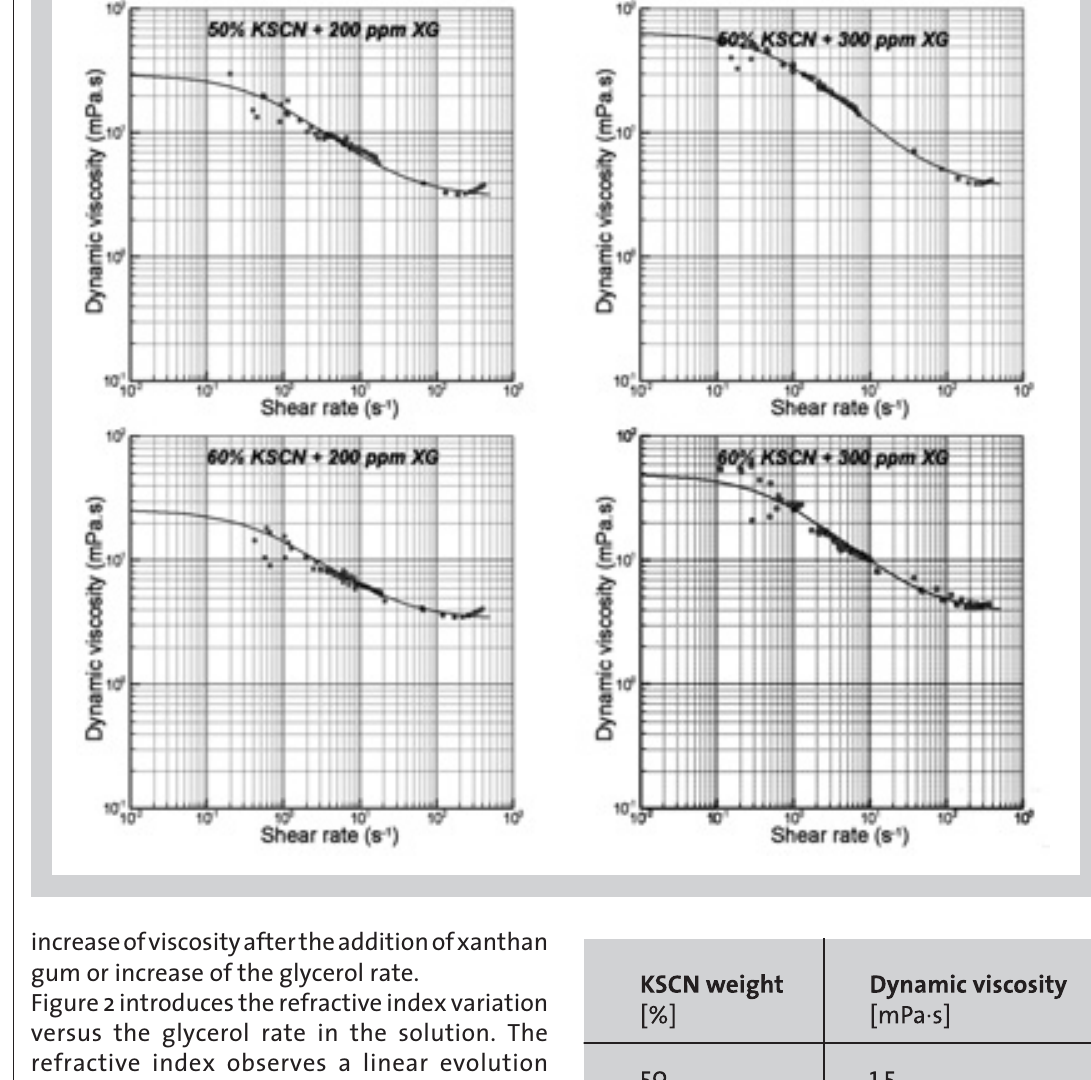
Figure 3: Viscosimetric evolution of the aqueous potassium thiocyanate solutions with 200 and 300 ppm of xan- than gum at 25°C. The full lines correspond to a Cross modified model fitted on the experimental data. Table 3: Dynamic viscosity of aque- ous potassium thiocyanate at